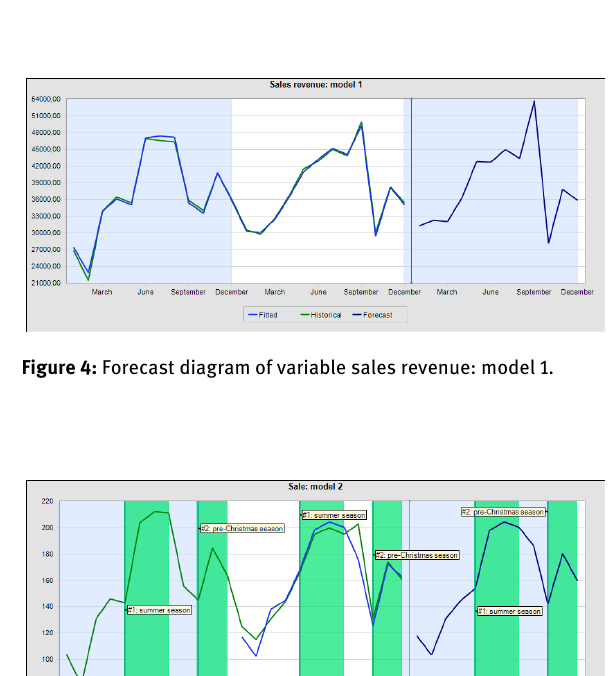
Figure 3: Forecast diagram of variable sale: model 1.